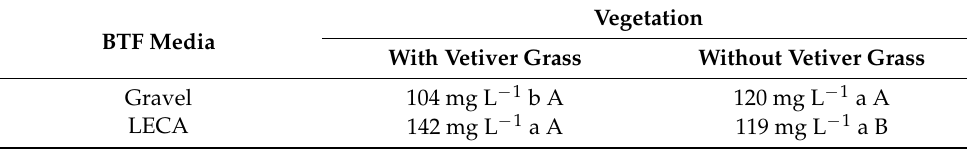
Table 3. Concentrations of BOD effluents in mg L − 1 . Factorial analysis regarding the interaction between the media and vegetation in BTFs, besides of effects caused by each